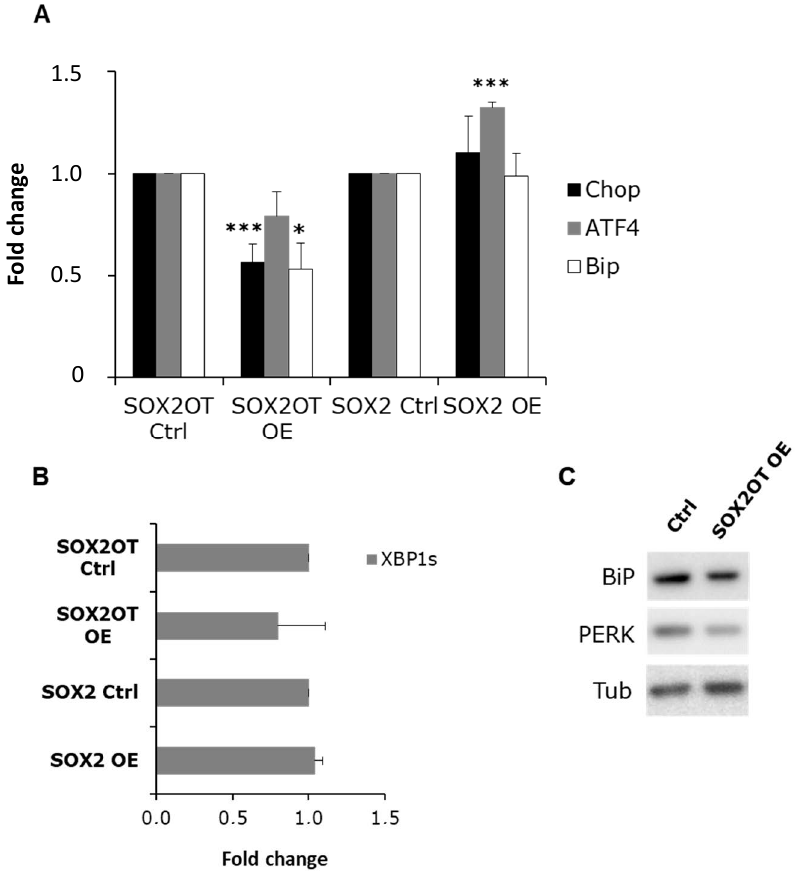
Figure 6. Effect of ectopic expression of SOX2OT or SOX2 on the UPR signalling pathway. MDA-MB-231 cells were transfected with plasmids containing the SOX2OT gene (NR_004053.3) or the SOX2 gene (NM_003106), or with their respective control vectors. ( A ): Expression of BiP, ATF4 , and CHOP relative to that of HPRT and GAPDH was measured by RT-qPCR. ( B ): Relative expression of XBP1s was measured by RT-qPCR relative to that of HPRT and GAPDH . ( C ): Protein expression levels of BiP and PERK were examined using Western Blot analysis. α -tubulin was used as loading control. Error bars represent standard deviations of three independent clones. * p < 0.05, ** p < 0.01, *** p < 0.001.